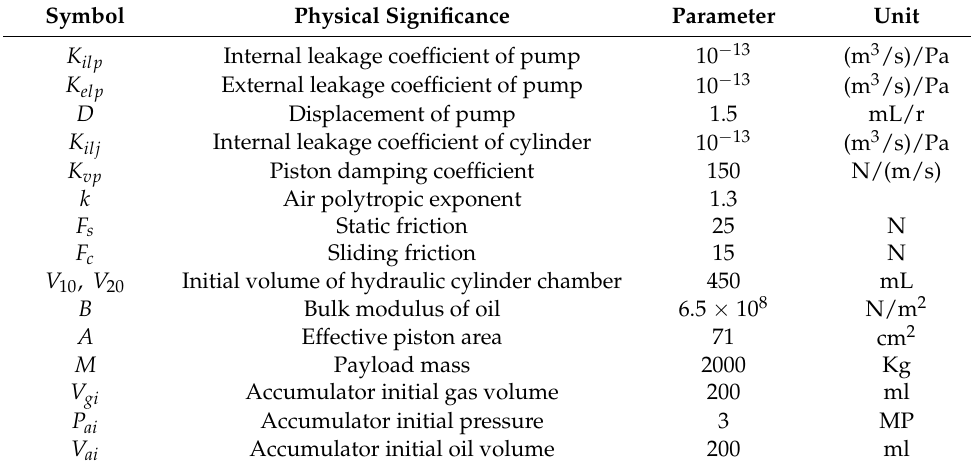
Table 2. EHA simulation model parameters.